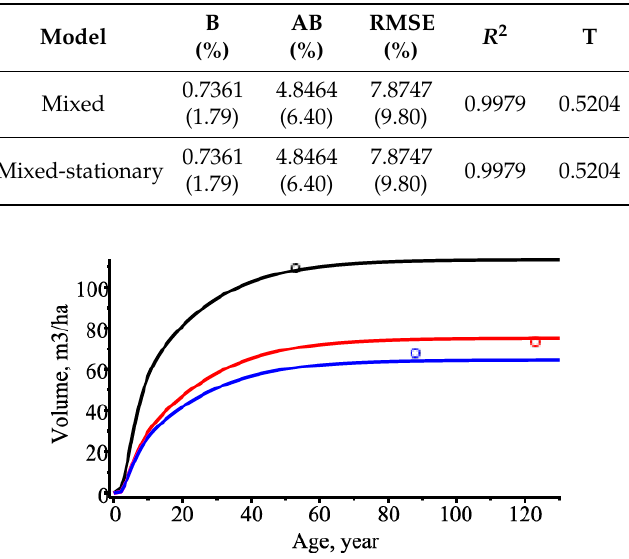
Figure 7. Evolution of stand volume per hectare over age for the mixed-effects scenario model: black, the first stand; red, the second stand; blue, the third stand; circles, observed values of the mean increments.